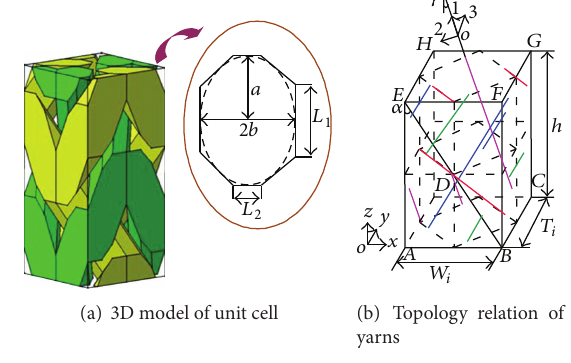
Figure 5: Unit cell